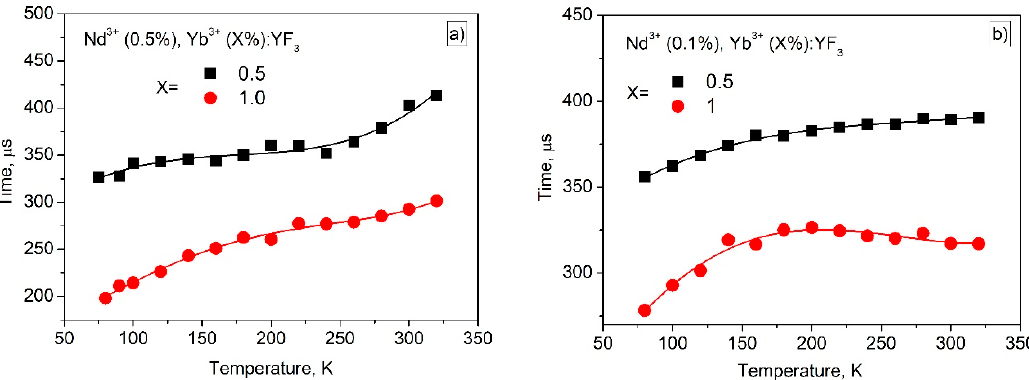
Figure 9. Effective luminescence decay times as functions of temperature for Nd 3+ (0.5 mol.%), Yb 3+ (X mol.%):YF 3 and Nd 3+ (0.1 mol.%) ( a ), Yb 3+ (X mol.%):YF 3 ( b ). (X mol.%):YF 3 and Nd 3+ (0.1 mol.%) ( a ), Yb 3+ (X mol.%):YF 3 ( b